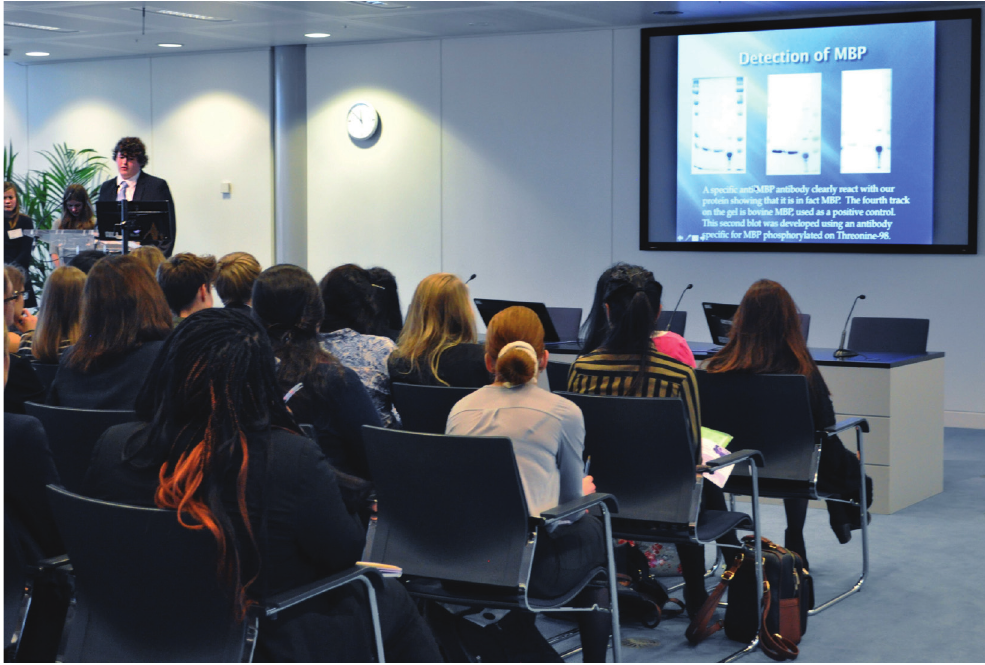
Figure 4: Students from the Simon Langton School present their work at the third Authentic Biology symposium